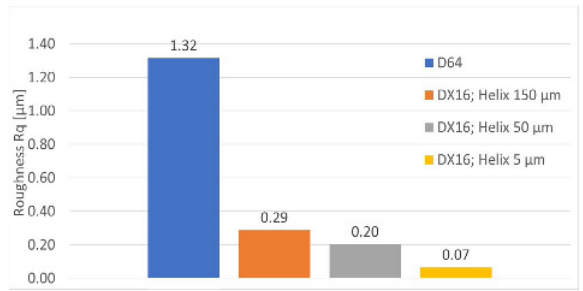
Fig. 5. Roughness results with different helical infeed depths at a feed speed of 300 mm/min